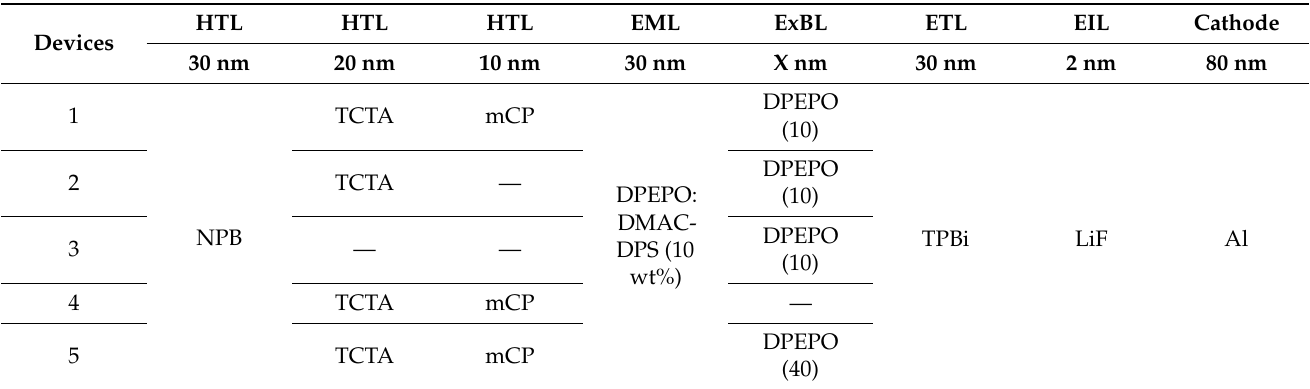
Table 1. Structures of the fabricated blue TADF devices.